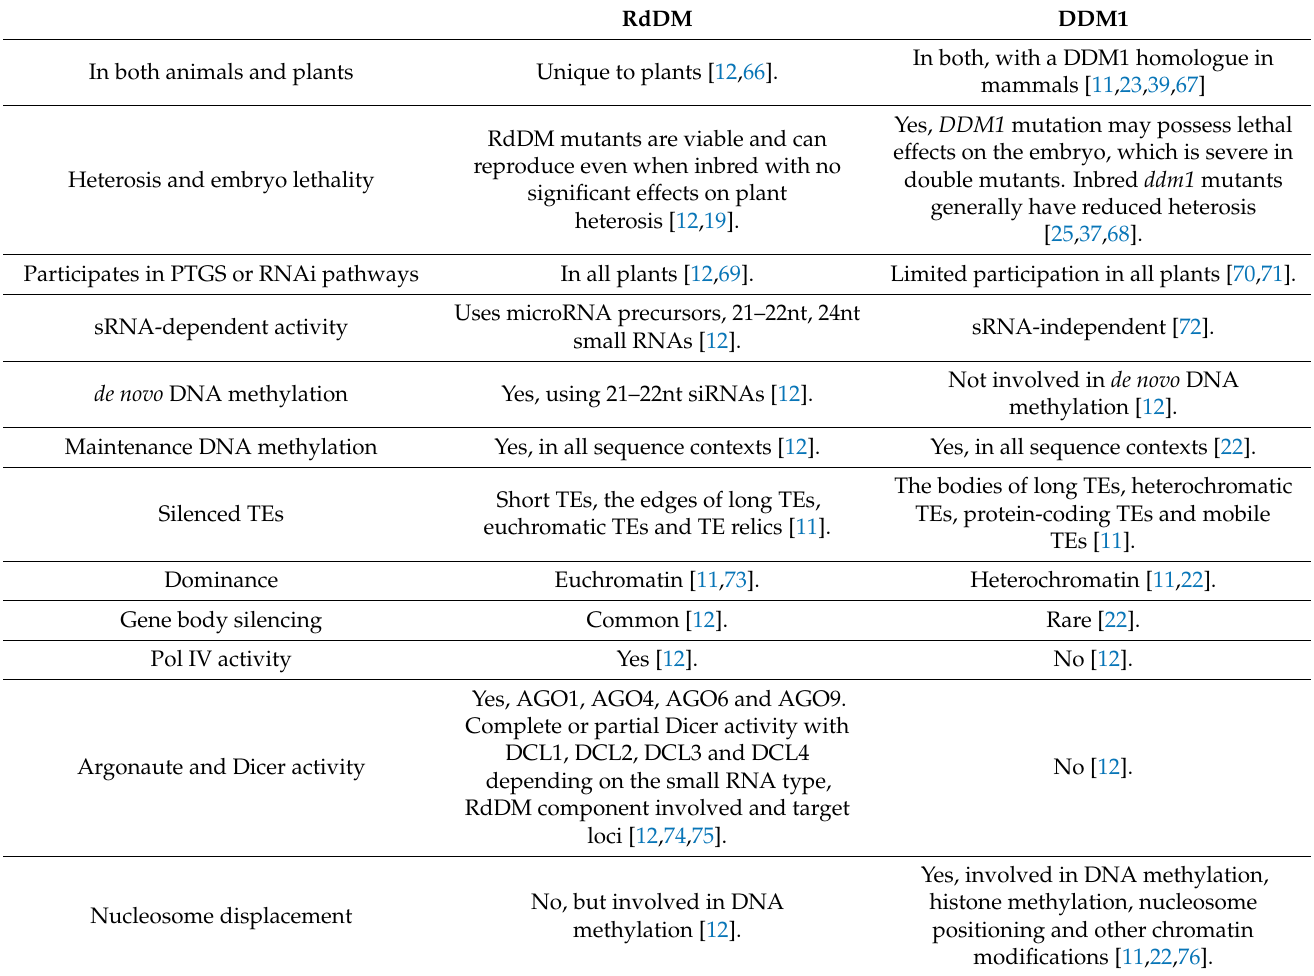
Table 2. The key features distinguishing DDM1- and RdDM-mediated epigenetic